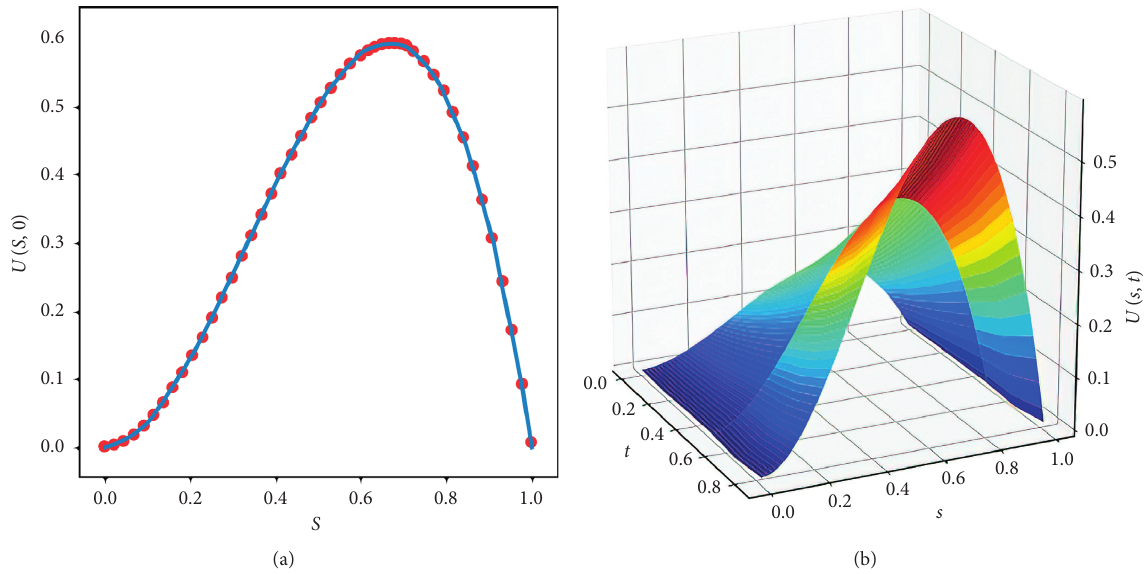
Figure 6: Plots of the approximated solutions of Example 2 when the number of hidden neurons is 60 and d t � 1/20. (a) U ( S, 0 ) (the red dotted plot shows the approximate solution). (b) U ( S, t ) , t ∈ [ 0 ,T ] .